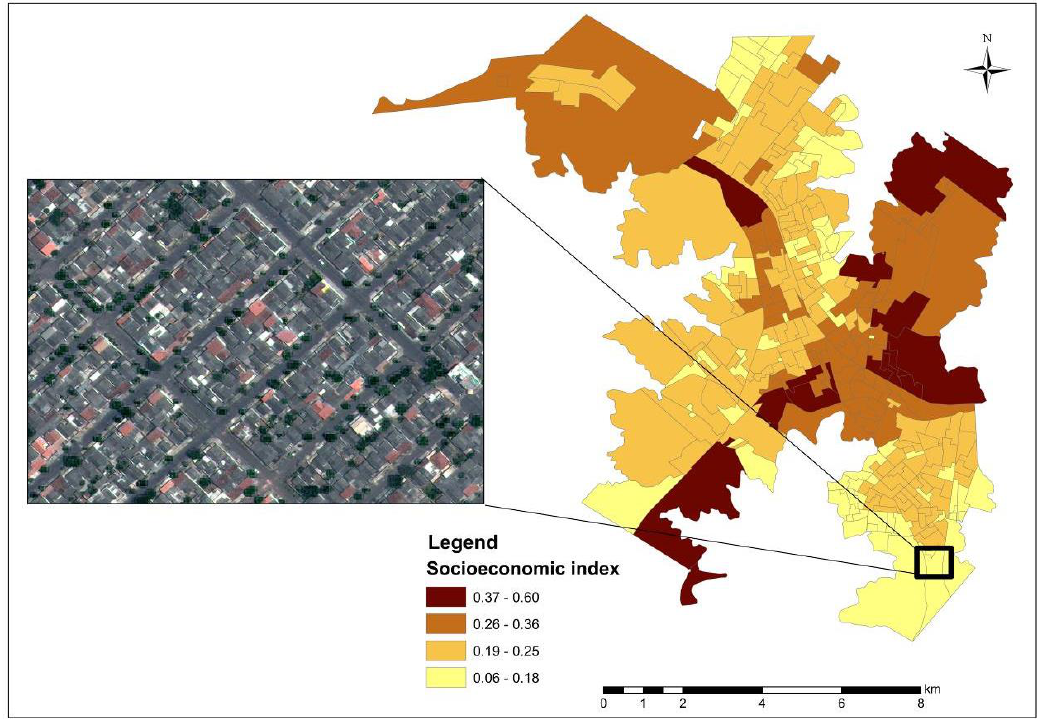
Figure 13. Illustration of the negative correlation among ceramic and cement roofs, arboreal vegetation, and socioeconomic level.